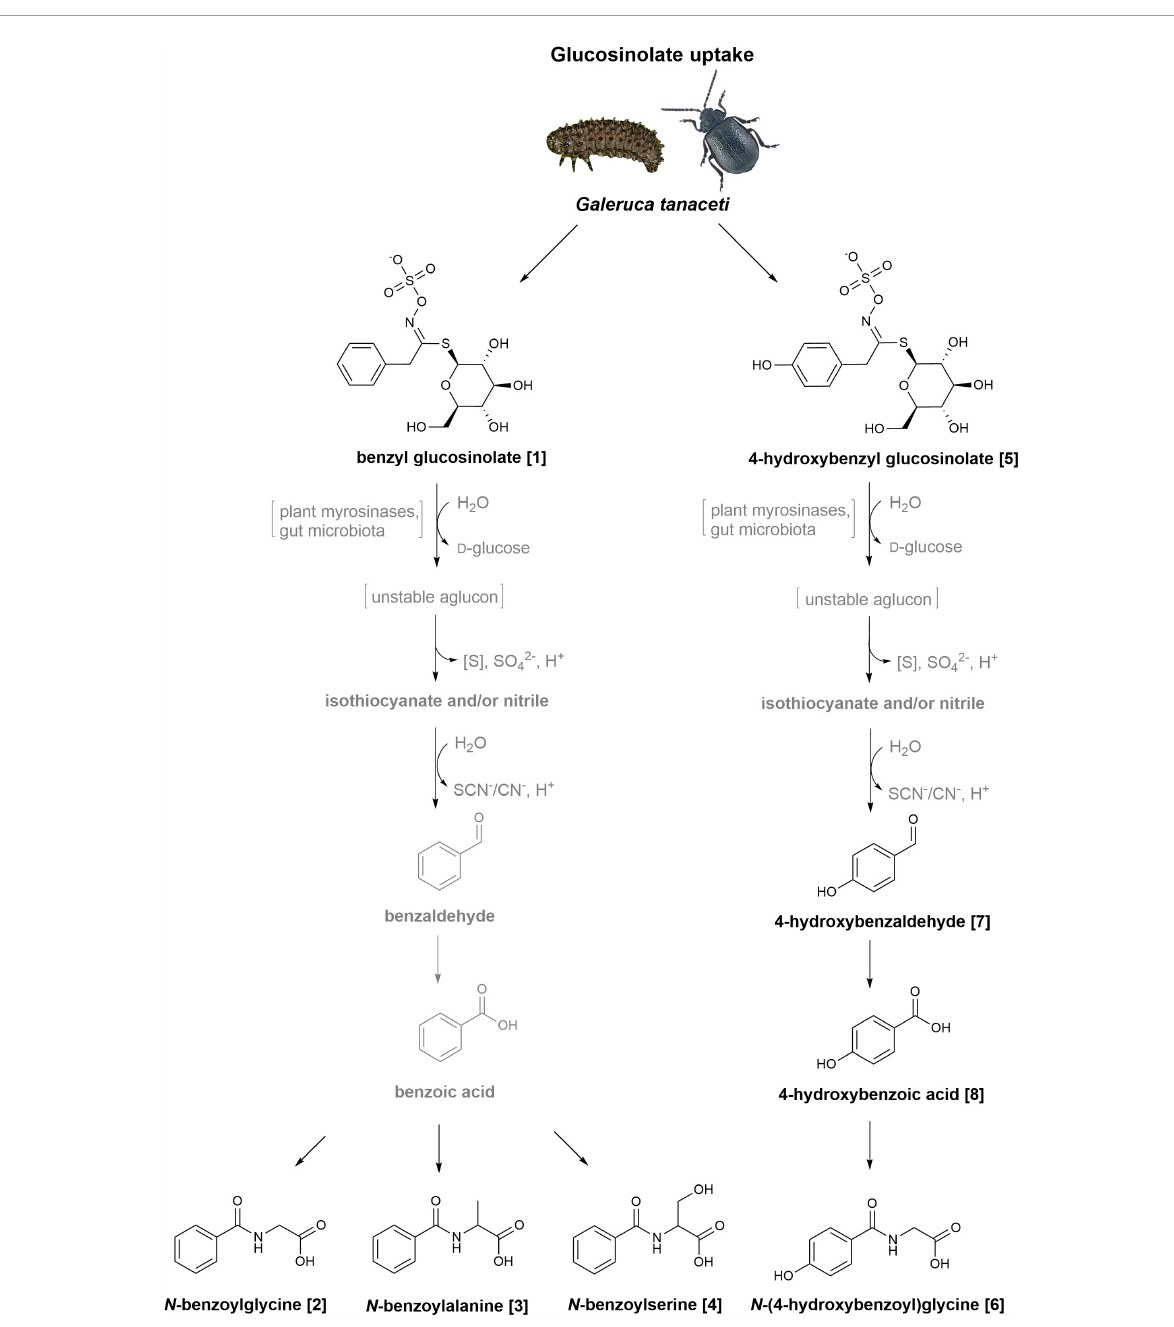
FIGURE4 Postulated metabolism of benzyl glucosinolate and 4-hydroxybenzyl glucosinolate in Galeruca tanaceti . The reaction pathways are based on metabolites found in samples (bodies, faeces) of larvae and adults fed with glucosinolate-treated cabbage or lettuce leaves. Glucosinolates are probably first hydrolysed to isothiocyanates and/or nitriles. The isothiocyanates then react to alcohols or amines (both not shown), which are oxidised to aldehydes, and further react to carboxylic acids. The nitriles are either converted directly to the carboxylic acids or also oxidised first to an alcohol, then to an aldehyde and then to a carboxylic acid. The carboxylic acids are probably metabolised to carbonyl-coenzyme A (CoA)-complexes or other activated carboxylic acids (not shown) and further conjugated with different amino acids based on the benzenic side chain. The putative intermediate derived from benzyl glucosinolate (1) is then conjugated with glycine, alanine or serine leading to N -benzoylglycine (2) , N -benzoylalanine (3) , and N -benzoylserine (4) , respectively, while for the intermediate derived from 4-hydroxybenzyl glucosinolate (5) conjugation with glycine leads to N -(4-hydroxybenzoyl)glycine (6) . The intermediates 4-hydroxybenzaldehyde (7) and 4-hydroxybenzoic acid (8) were detected in individuals fed with 4-hydroxybenzyl glucosinolate; the corresponding intermediates for the benzyl glucosinolate treatment were not detectable. Putative intermediates are shown in grey, if they were not detectable in insect samples but are probably part of the putative metabolism in G. tanaceti